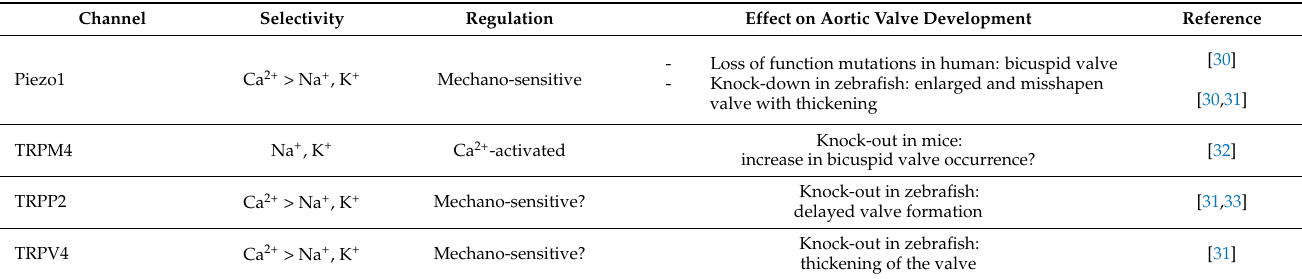
Table 1. Ion channels are involved in aortic valve